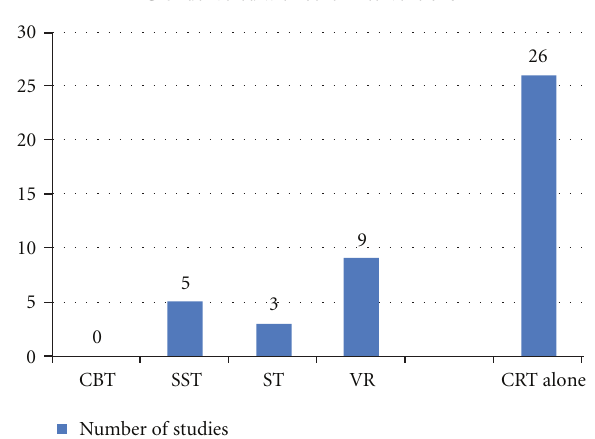
Figure 2: Data from the meta-analytic studies by McGurk et al. [1] and Wykes et al. [2]. CBT: Cognitive behavioral therapy; SST: social skills training; ST: skills training; VR: vocational rehabilitation; CRT alone: cognitive remediation therapy as stand-alone